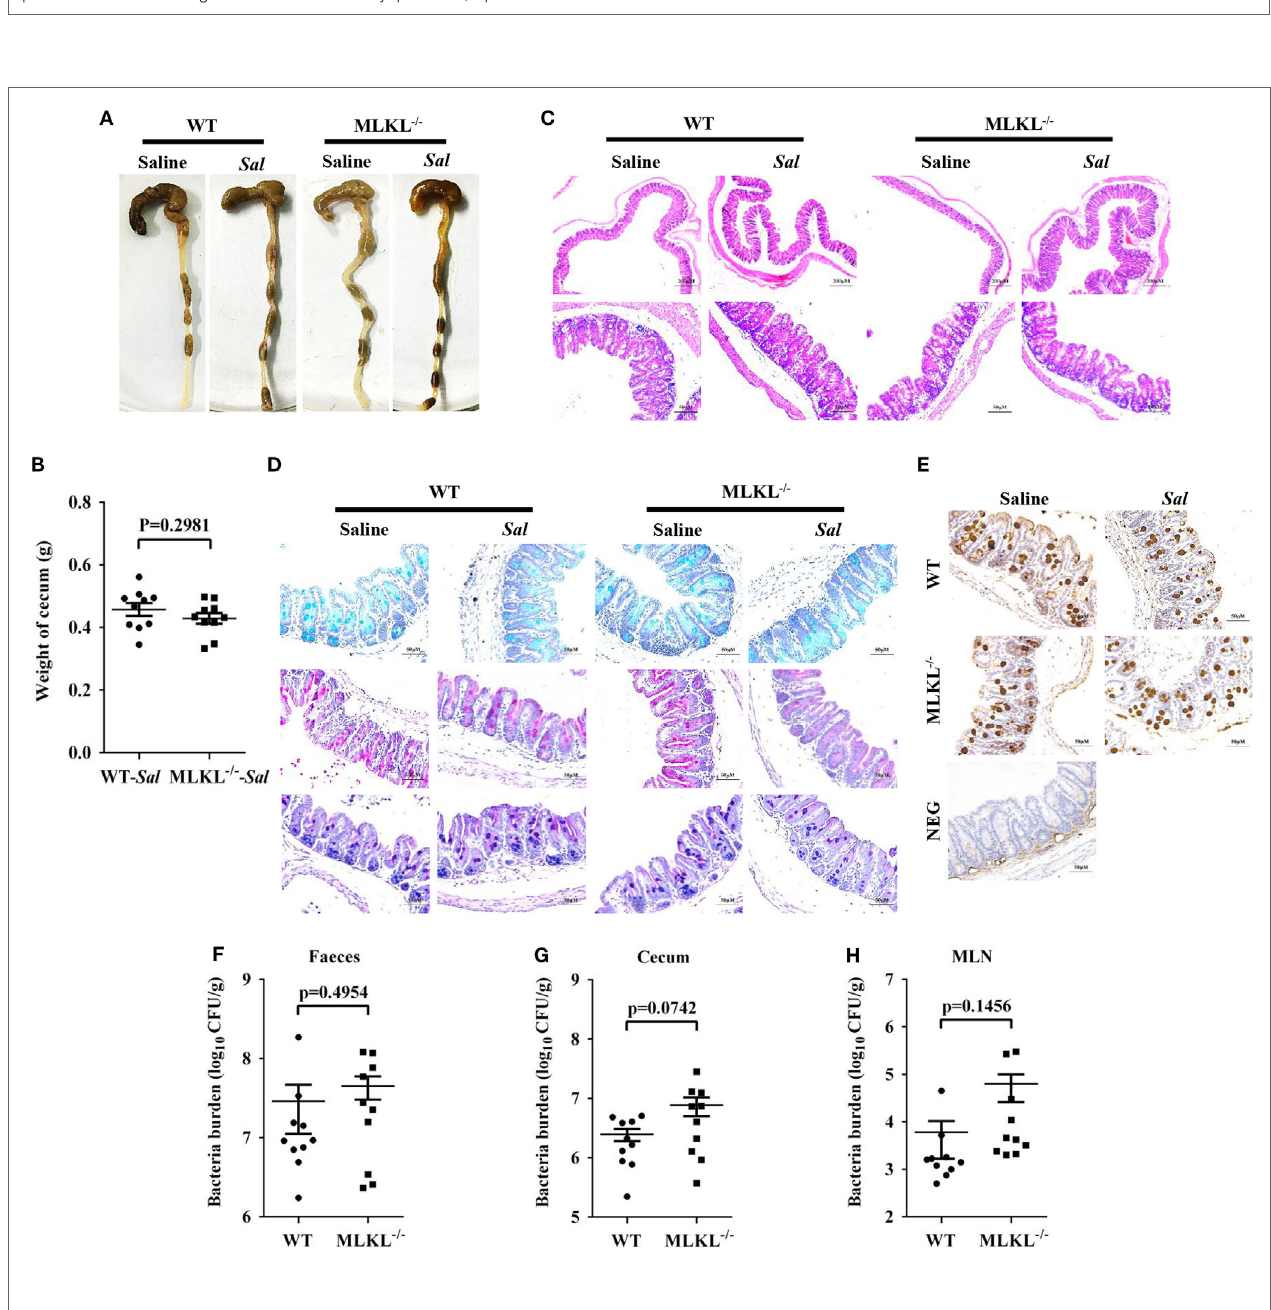
FigUre 4 | MLKL deficiency leads to severe disruption of intestinal mucosal barrier following Salmonella intestinal infection. Streptomycin-pretreated WT and MLKL − / − mice were orally infected with Salmonella (5 × 10 7 CFU) (n = 10 each group) for 48 h. (a) AB-PAS staining. (B) Mucin 2 (IHC) stained brown. (c,D) PCNA and TUNEL staining of proliferating cells and apoptotic cells in the cecum tissue, respectively. The cecum tissue mRNA was examined for Occludin (e) and ZO-1 (F) and claudin 3 (i) by QRT-PCR. The data were normalized to GAPDH expression and are showed as the fold increase in mRNA. (g) Claudin-3 (IHC) stained brown. (h) The cecum tissue lysate was analyzed for claudin-3 by western blotting. GAPDH was used as a loading control. (J) The intestinal permeability was measured using FITC-dextran as described in Section “Materials and Methods” (n = 5–7 each group). All data are shown as mean ± SEM. Student’s t- test was performed. Statistical significance is indicated by * p < 0.05, ** p <